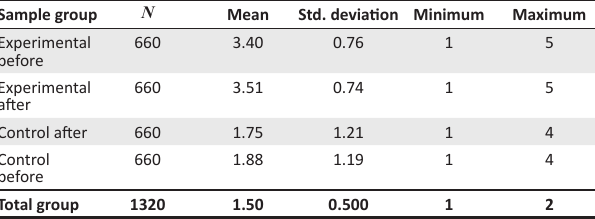
TABLE 2: Descriptive statistics.